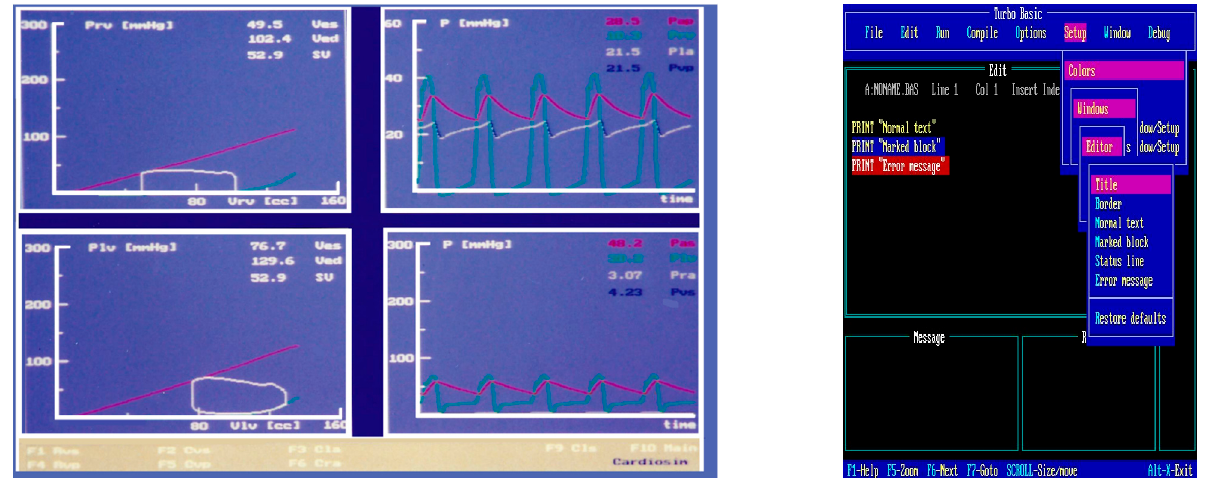
Figure 2. Screen output ( left ) from the first version of CARDIOSIM © implemented using Turbo Basic language. Left lower (upper) window: left ( right ) ventricular pressure–volume loop with stroke volume (SV) and end-systolic (Ves) and end-diastolic (Ved) volume values. Right lower side of the screen output: instantaneous waveforms and mean values (calculated during a cardiac cycle) of systemic arterial (Pas) and right (Pra) atrial pressures. Right upper side of the screen output: instantaneous waveforms and mean values (calculated during a cardiac cycle) of pulmonary arterial (Pap) and left (Pla) atrial pressures. Right side: screenshot of the Turbo Basic language development environment.